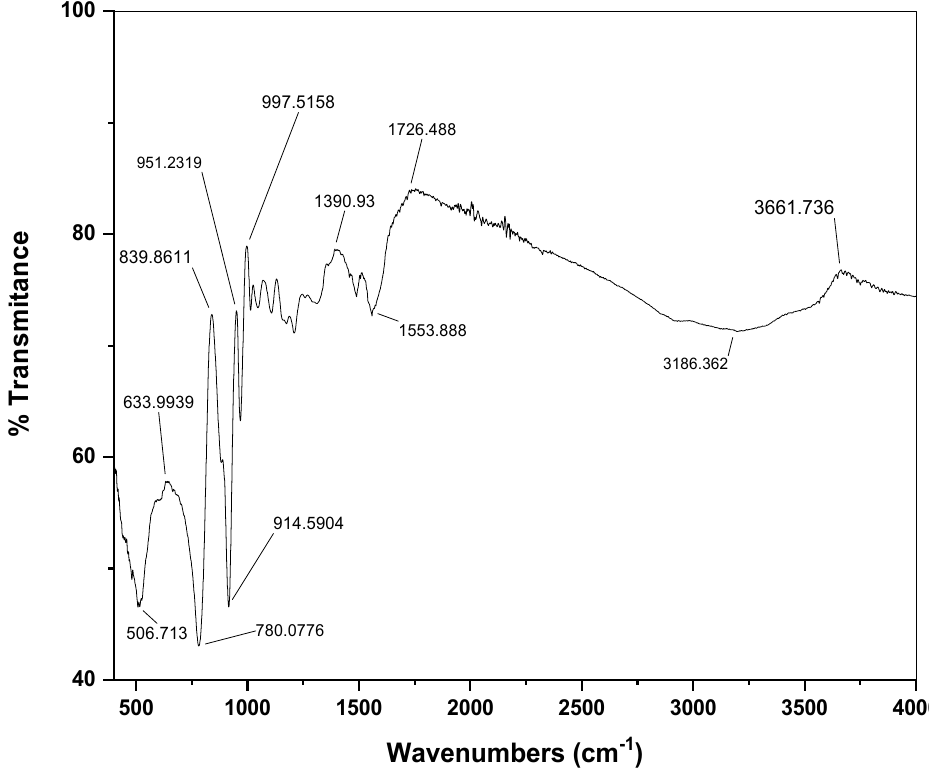
Figure 3. FTIR spectra of PNMPy/nano-Stannous(II)WO 3 composite in KBr showing different bonding stretching.